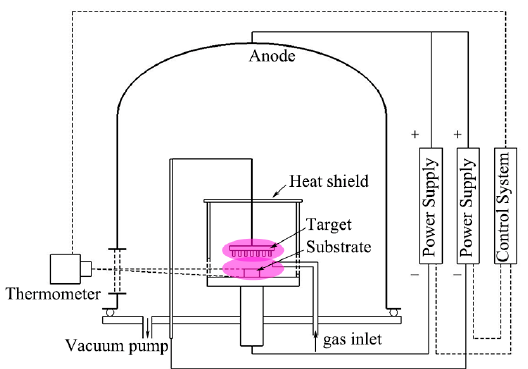
Figure 1. The schematic diagram of the plasma surface metallurgy technique (PSMT) furnace.